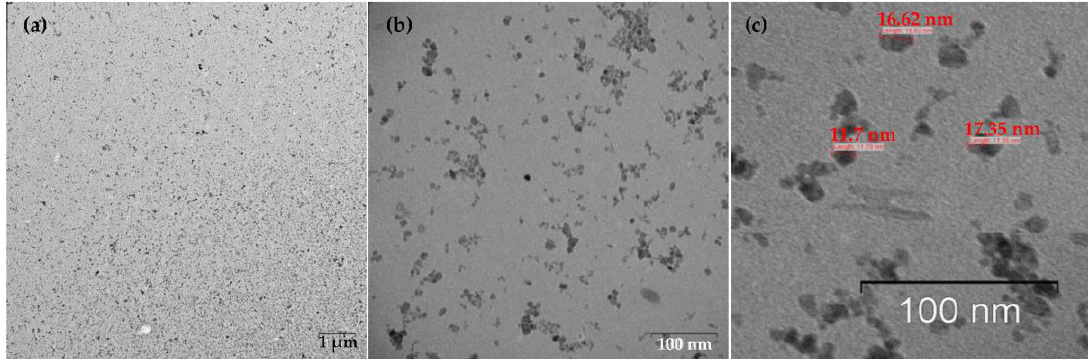
Figure 2. TEM images of MNPs. ( a ) Low magnification TEM image, the bar indicates one μ m, ( b ) High magnification TEM image, the bar shows 100 nm. ( c ) TEM image reveals the MNPs size (~16–17 nm), monodisperse, and balls-like nature.